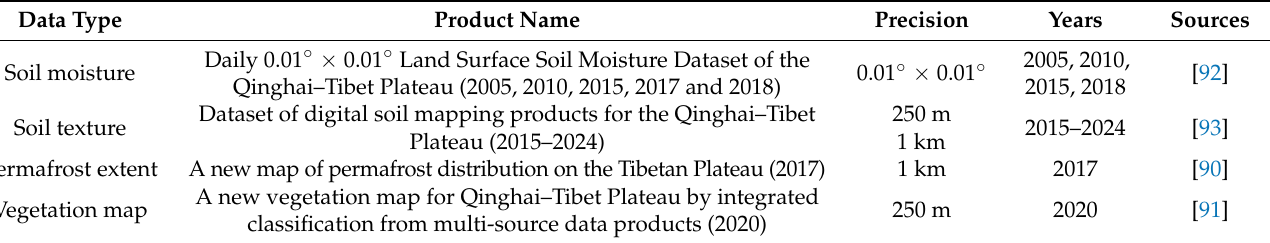
Table 3. Data products used in this